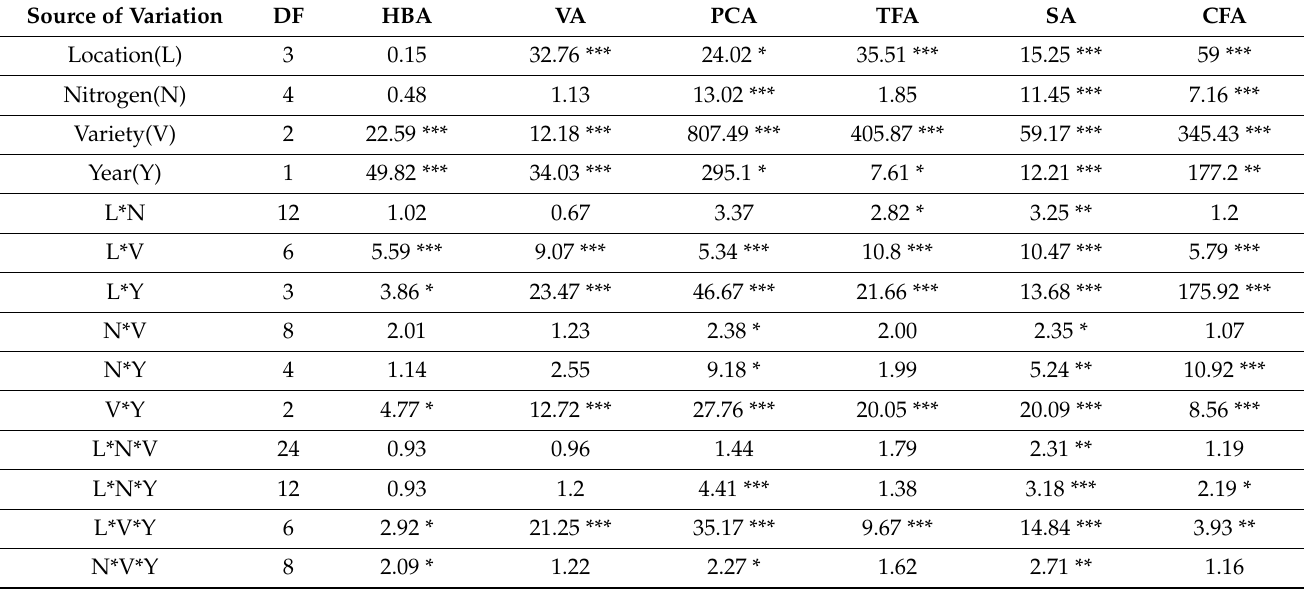
Table 1. Analysis of variance (ANOVA) for phenolic acid composition of wheat varieties under the conditions of different